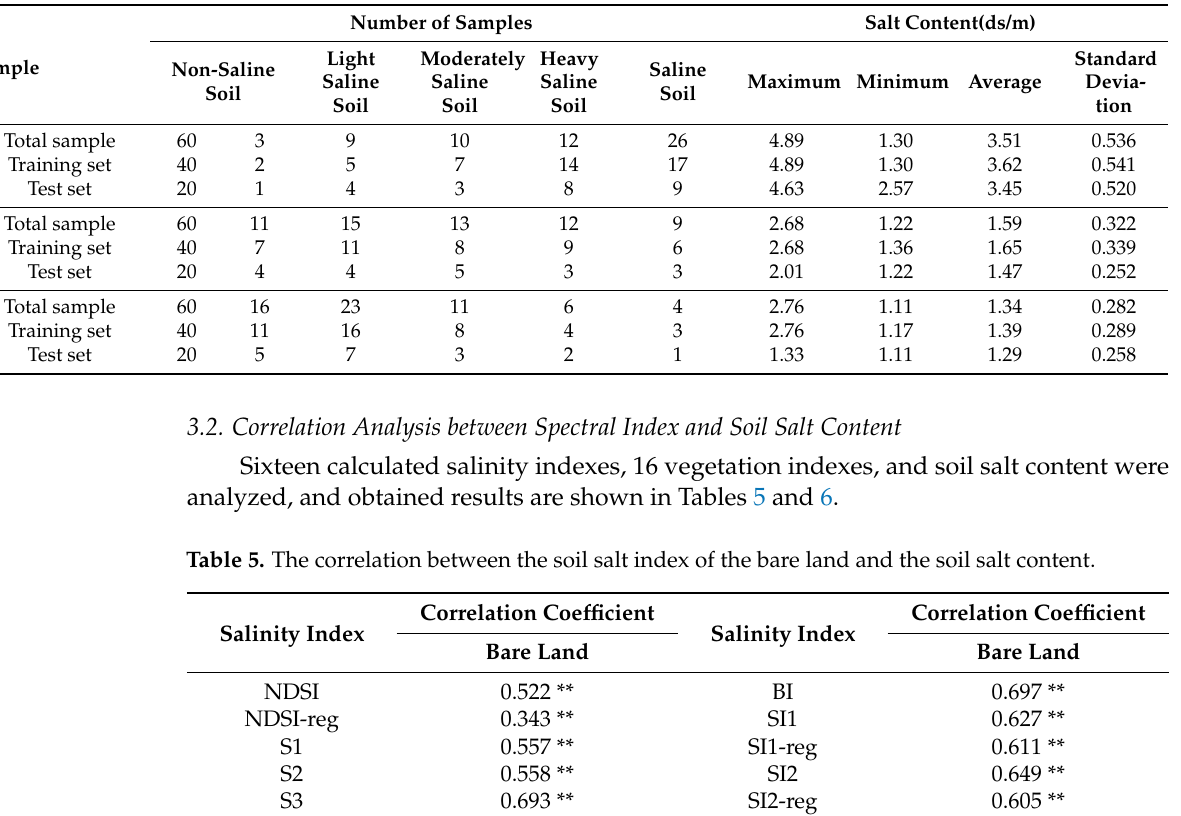
Table 4. The statistical analysis of soil salinity.